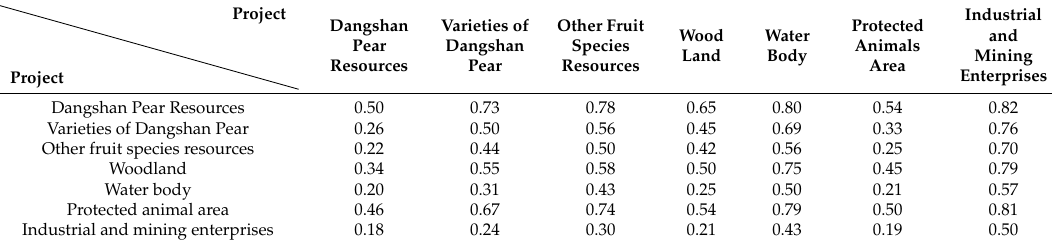
Table 9. Survey results of tourist